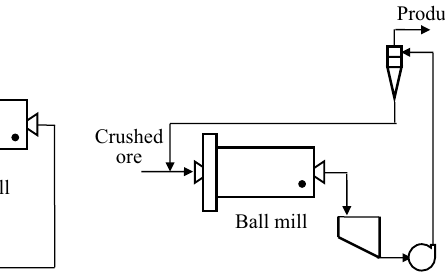
Fig . 3. Schematic overview of one- stage grinding process, based on the use of ball mills